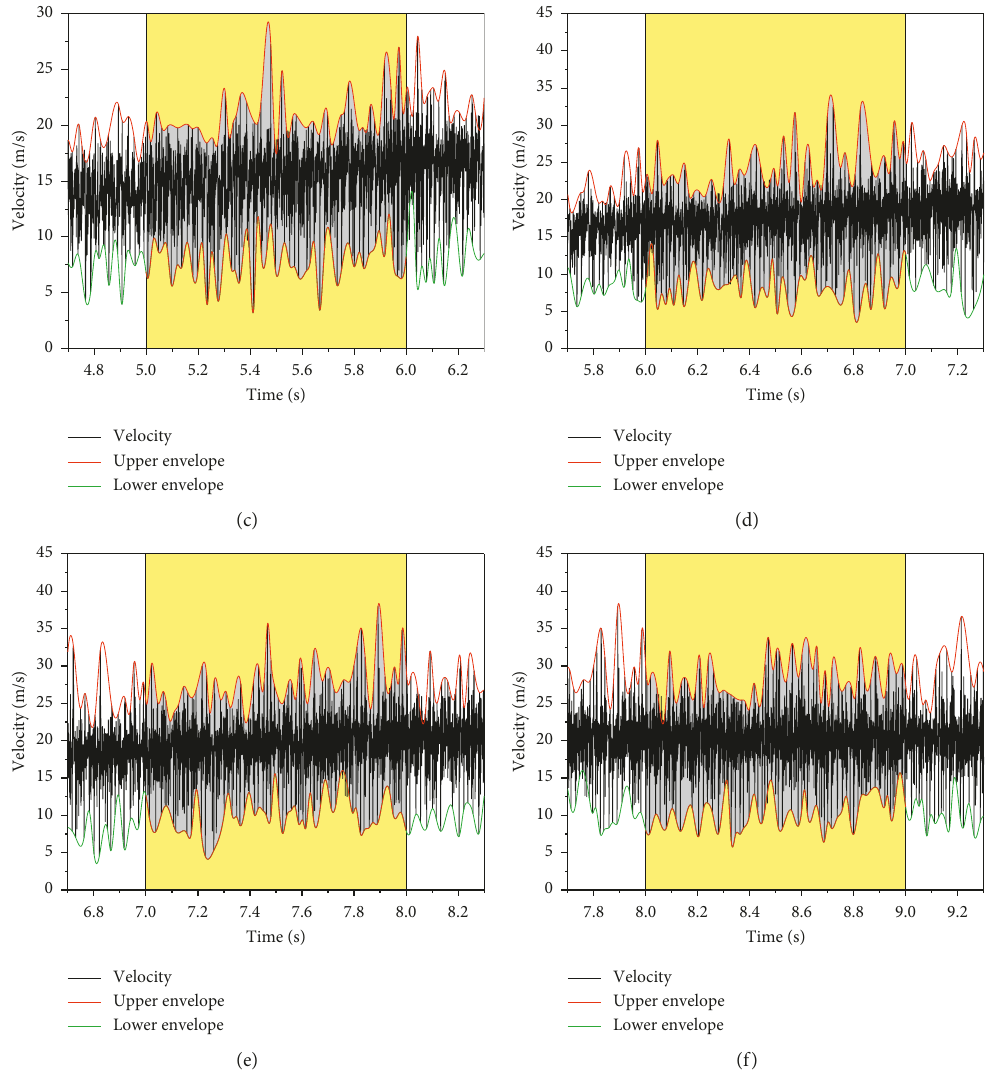
Figure 17: Curve for relationship between velocity and time at different flow rates. (a) Area Q 5.4m 3 /h. (c) Area (cid:31)